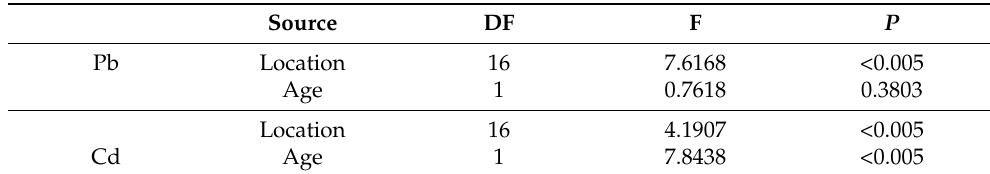
Table 3. Two-way ANOVA showing variation in heavy metals between the location and age in the samples of hare